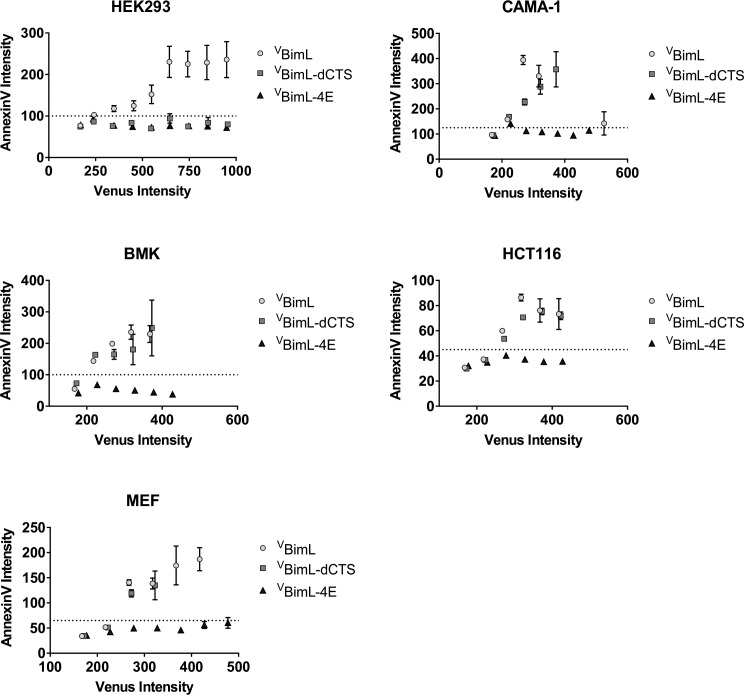
Correlation between expression of VBH3-proteins and apoptosis measured as Annexin V labeling.For each cell line, the Annexin V Rhodamine intensity per cell was plotted against the Venus intensity per cell. The Venus intensity acts as a surrogate for the relative amount of each of the BimL mutant proteins expressed in one cell. Cells with intensity in the Venus channel equal to or less than the mean signal from untransfected cells were pooled as the first point, the subsequent points are data from intensity bins with arbitrary 50 unit increments. The horizontal dotted line indicates two standard deviations above the signal from untransfected cells in the AnnexinV channel. The cell line is indicated at the top of each panel.Figure 1—figure supplement 1—source data 1.Source data of binned Venus intensities and Annexin V positivity.